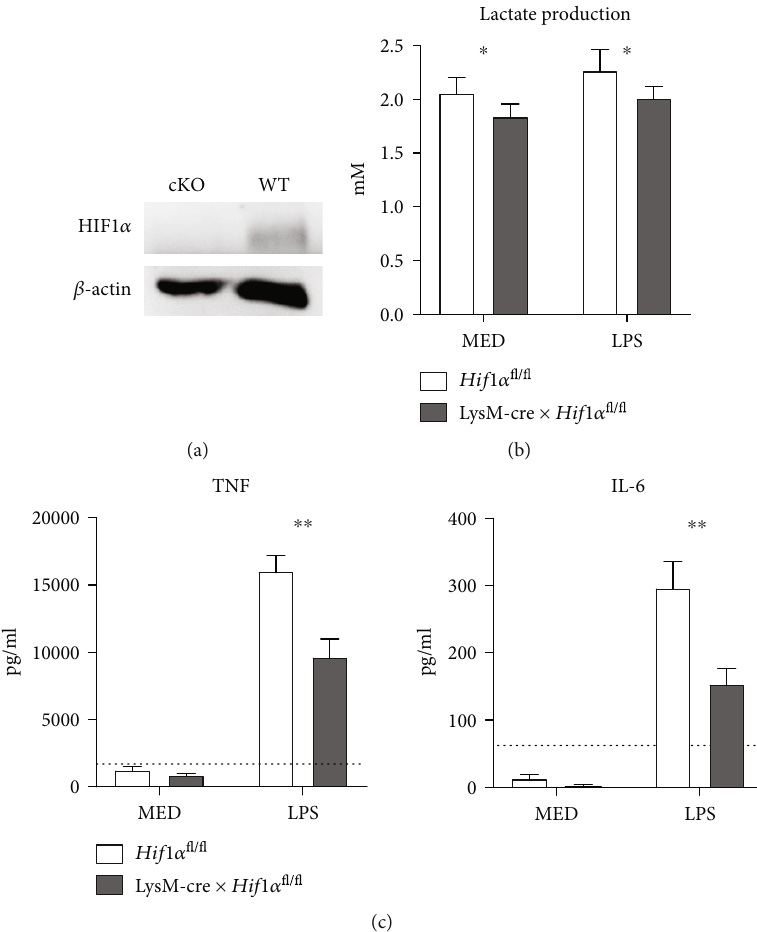
Figure 1: HIF1 α is important for glucose metabolism and TNF production of alveolar macrophages. HIF1 α protein expression in AMs derived via BAL from naïve LysM-cre × Hif1 α fl / fl mice (cKO) and littermate controls (WT) treated with IOX2 for 24 hours (a). Lactate (b) and cytokine (TNF and IL-6) production (c) by AMs stimulated in vitro with LPS or left untreated for 24 hours. Data are shown as bar graphs showing mean with standard error of the mean from 6 technical replicates of pooled AMs from 7 mice per group. Dotted line indicates the reliable lower limit of detection of the cytokine assays. Lactate production by LysM-cre × Hif1 α fl / fl AMs was compared to that of control AMs ( Hif1 α fl / fl ) of mice using t -tests. TNF and IL-6 production of LPS-stimulated cKO AMs and control AMs was compared using the Mann-Whitney test. ∗ P < 0 : 05 ; ∗∗ P < 0 : 01